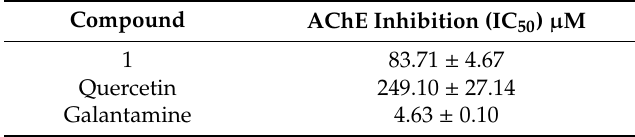
Table 3. IC 50 values of compound 1 against AChE compared to quercetin and